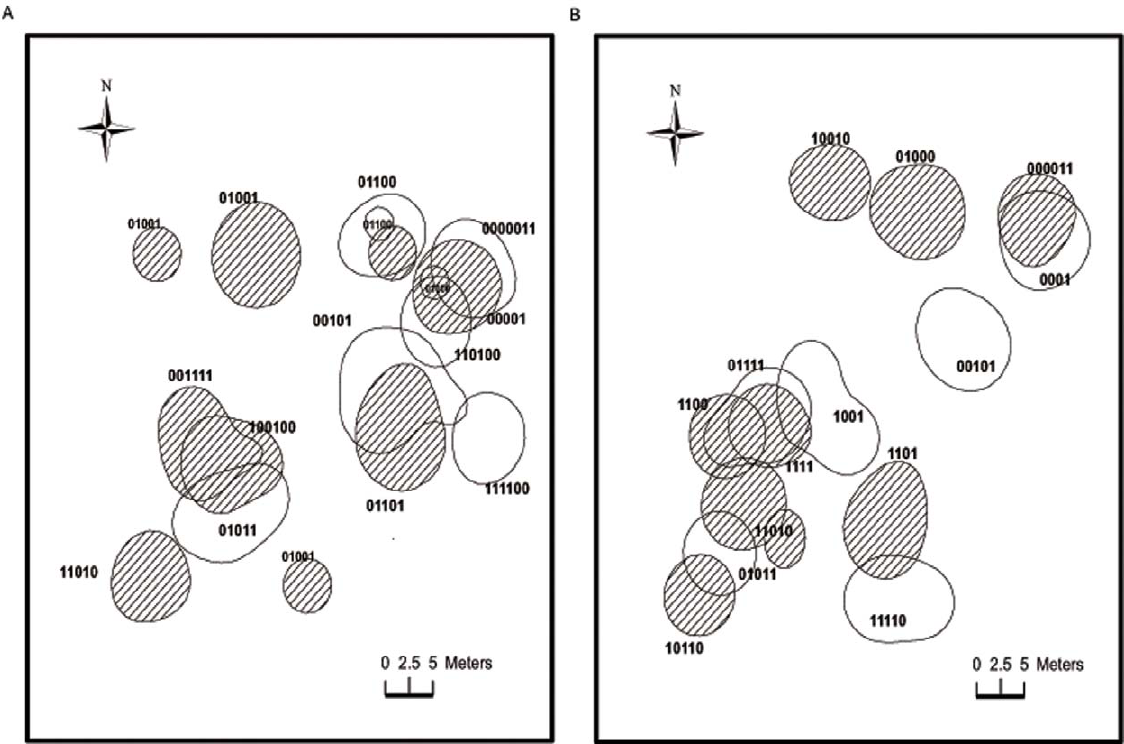
Figure 2. Spatial distribution of Phrynocephalusvlangalii . Spatial distribution and 75% Kernel home ranges of a subset of male (n=12) and female (n=14) lizards collected during A) 2009 and B) 2010. Cross-hatching refers to females, empty spaces to males. Males (01011 and 00101) and female (11010) were marked in 2009 and recorded at the same position in 2010. Some individuals have two spatially separate areas because the Kernel method calculates areas of intensive use (see Methods). doi:10.1371/journal.pone.0041130.g002 PLoS ONE |